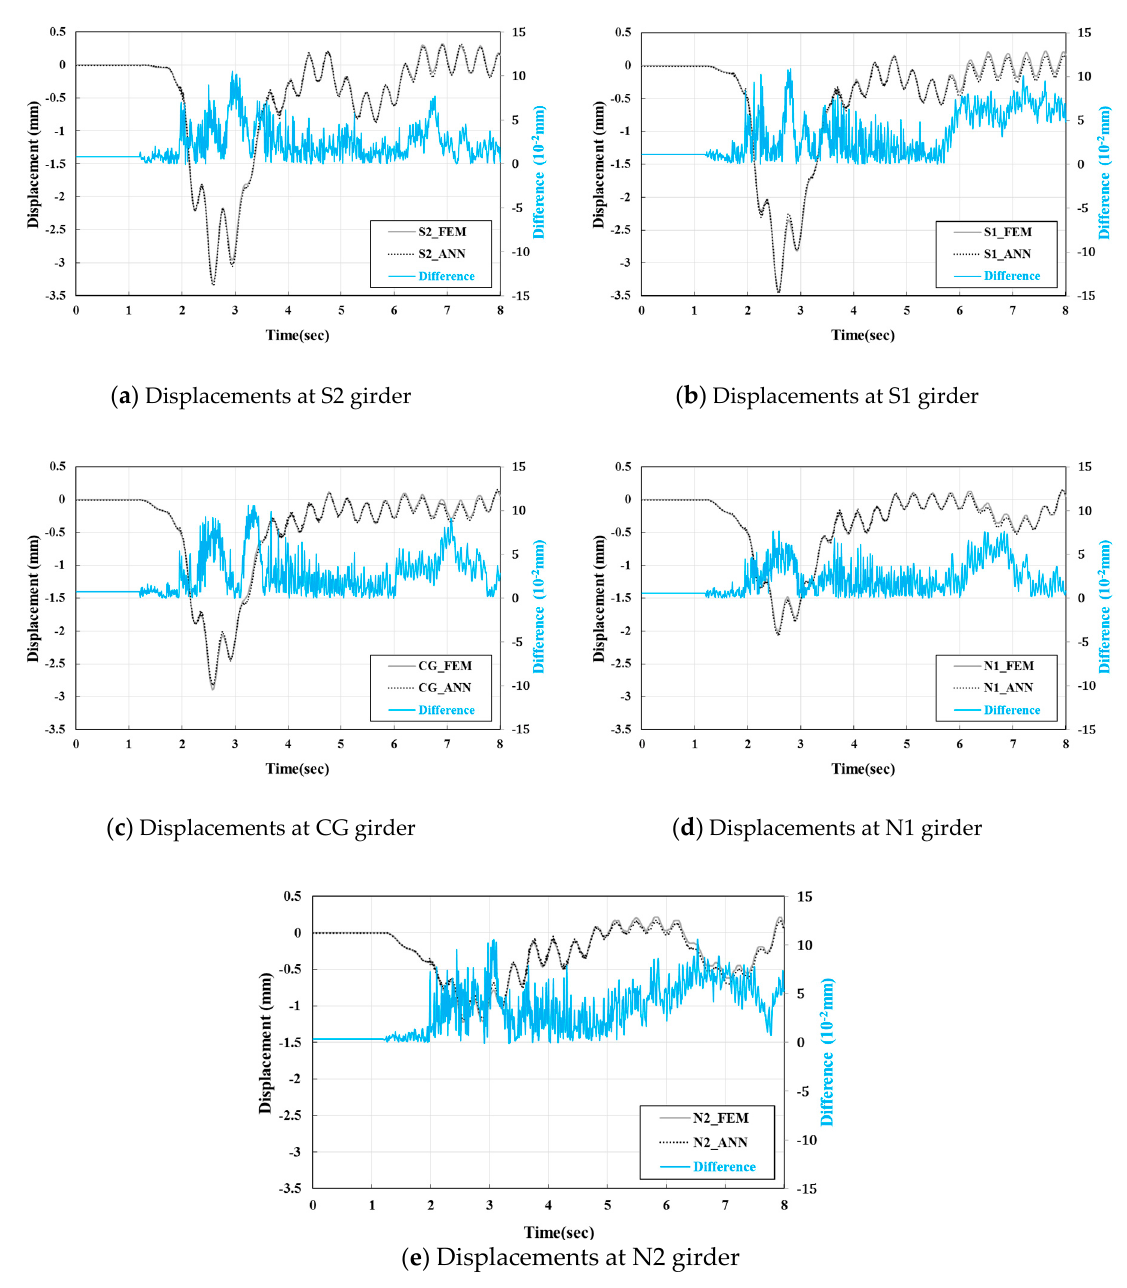
Figure 13. Test results at midpoint of girder for 80 km/h.